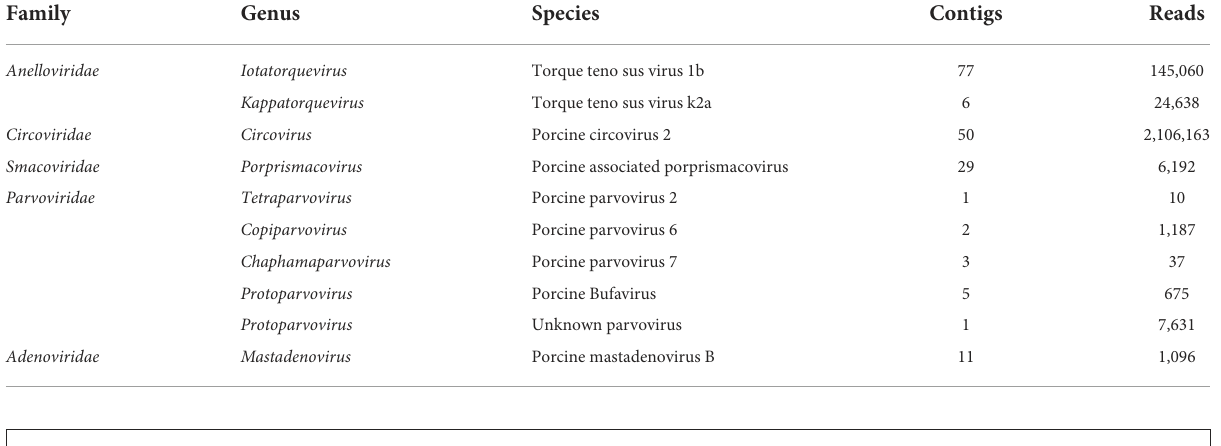
TABLE 1 The vertebrate-associated virus annotation results in DNA virome of pig lung. Family